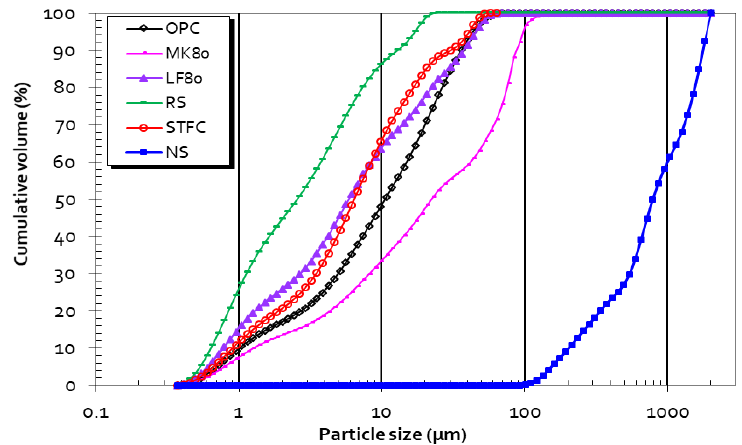
Figure 3. Particle size distribution for OPC, MK80, LF80, NS, RS, and STFC.